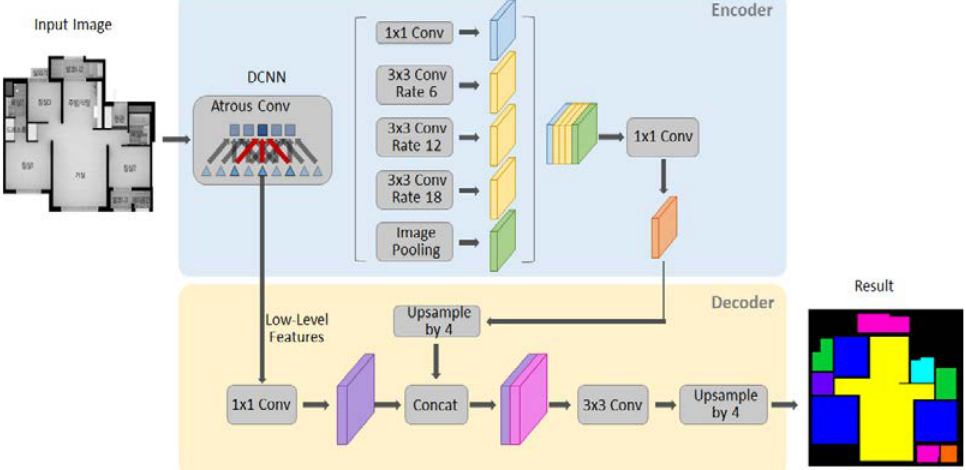
Figure 8. Deep Learning Process using DeepLabV3+.